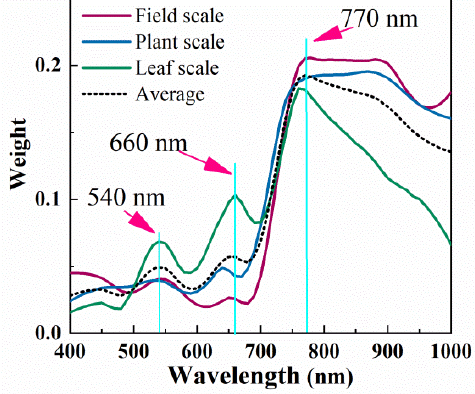
Figure 8. Multi-scale sensitive wavelength selection. Table 6. Classification results of individual-scale sensitive wavelengths, multi-scale sensitive wave- lengths, and full